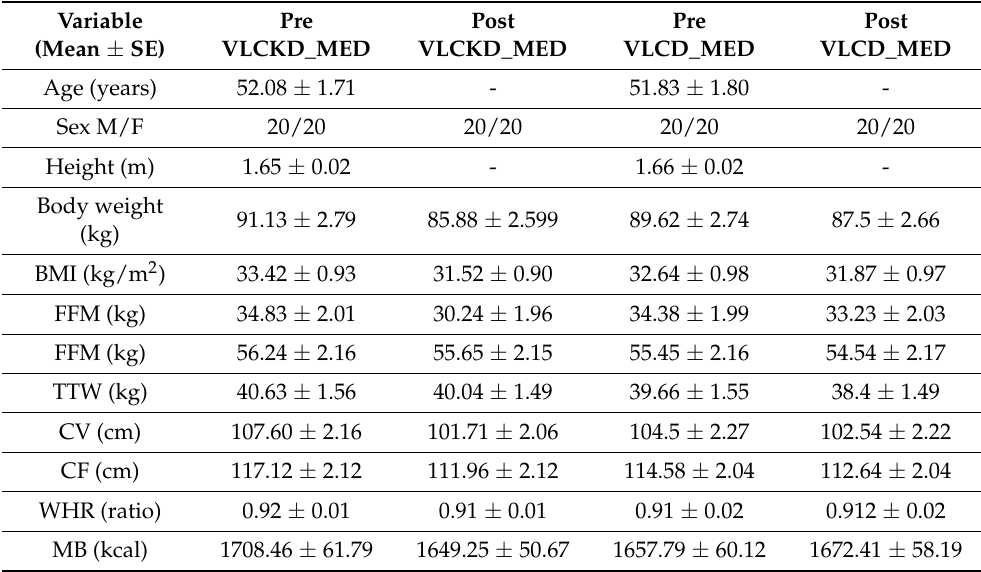
FFM: free fat mass (kg); TBW: total body water (kg), MB: basal metabolism (kcal); BMI: body mass index (kg/m 2 ); CV: waist circumference (cm); CF: hip circumference (cm); WHR: waist to hip ratio (ratio); “-” no change to the previous paired